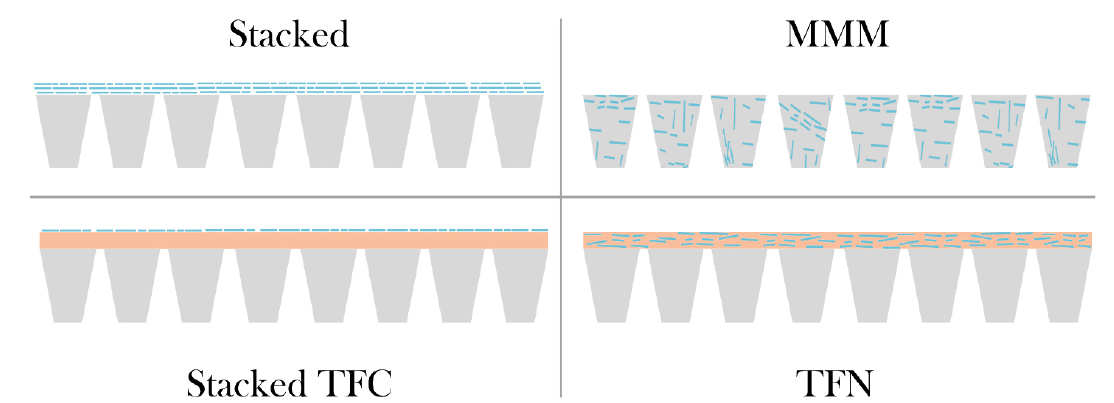
Figure 3. The types of nanosheet membranes that demonstrate improved membrane performance in terms of fouling mitigation. Other types of nanosheet membranes have the nanosheets dispersed in the support layer of a Thin Film Composite (TFC) membrane, or consist of a porous monolayer nanosheet. The illustration depicts as ideal porous polymer substrate with a cross-sectional view. Blue rectangles represent nanosheets that are either immersed in the grey polymer support and the orange PA layer, or stacked on top of the polymer and the